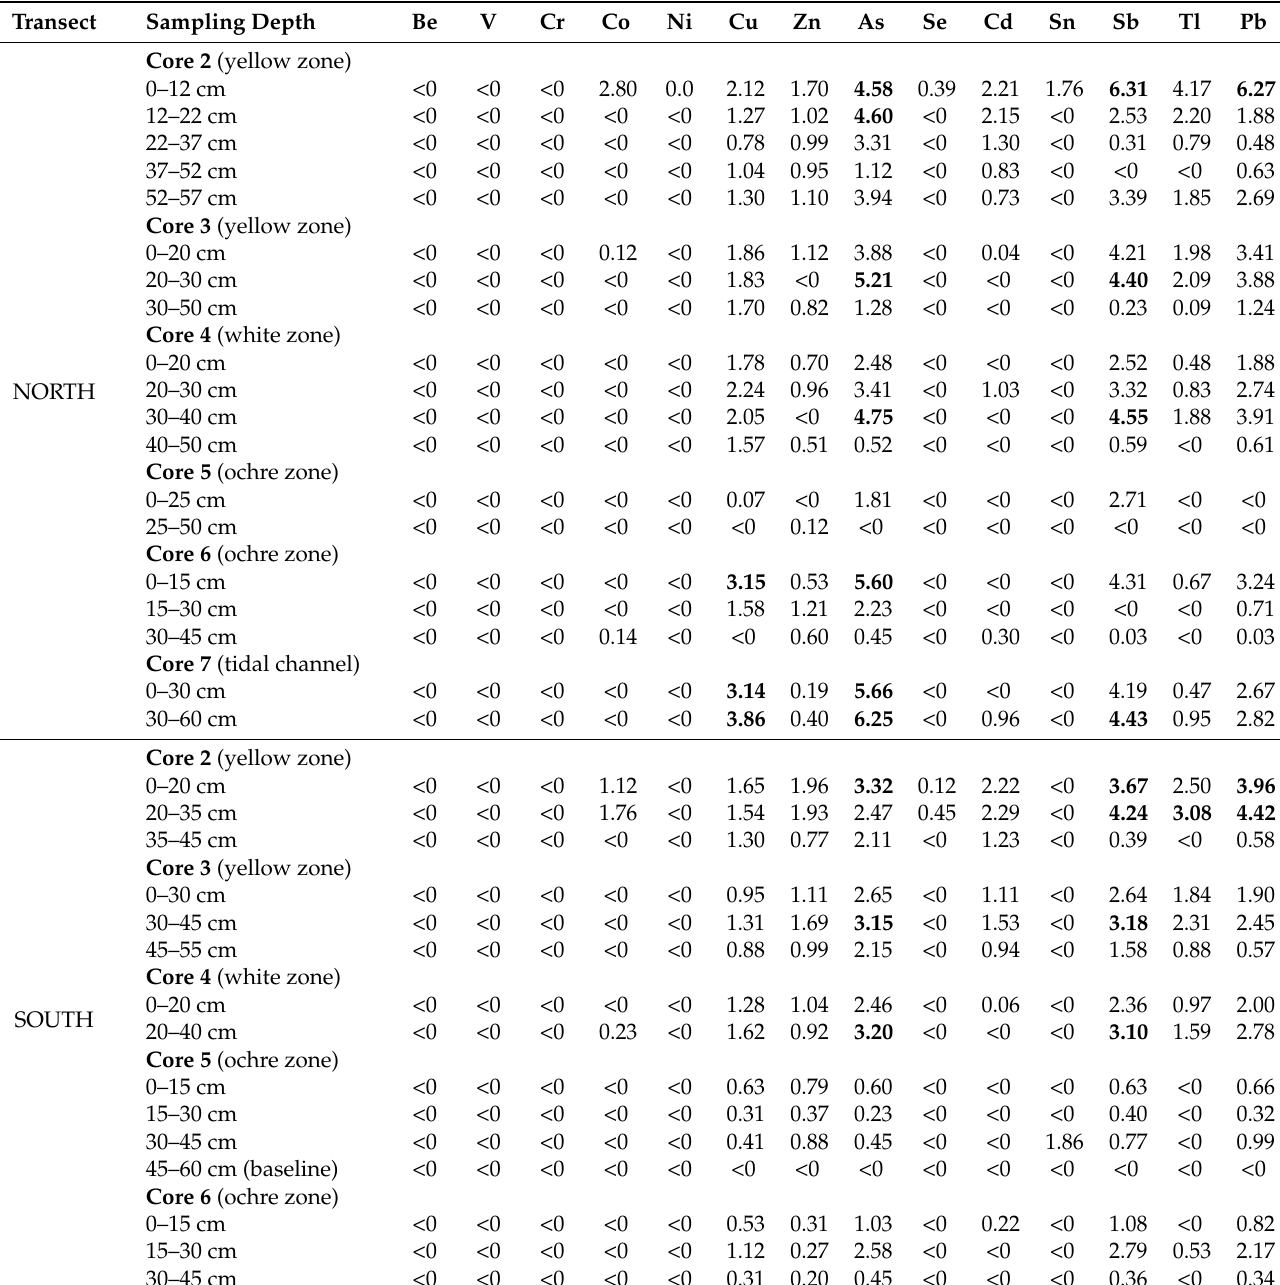
Table 5. I geo values for trace elements in the core soil samples. Values in bold are indicative of heavily contaminated (3 < I geo ≤ 4), heavily to extremely contaminated (4 < I geo ≤ 5) and extremely contaminated (I geo > 5)